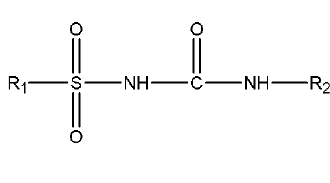
FIGURE 1. Chemical structure of sulfonylurea herbicides.